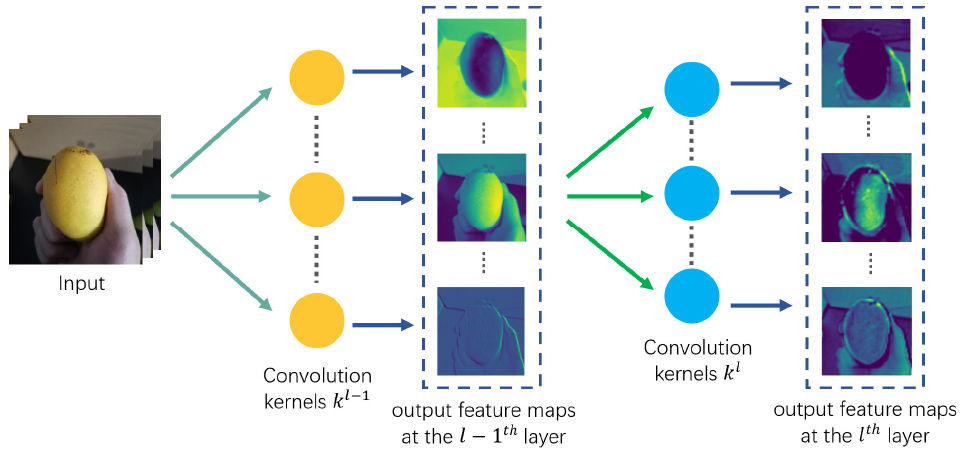
Figure 3. Output feature maps of the middle layer of CNN.